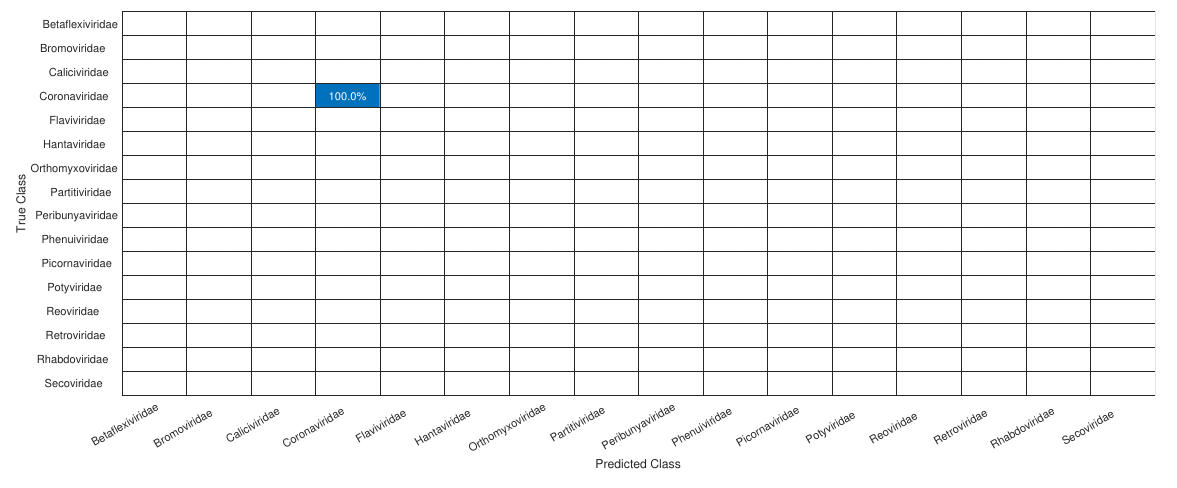
Figure 7. Confusion matrix for the test of the CNN for the classification of the SARS-CoV-2 in its correct family ( Coronaviridae ).